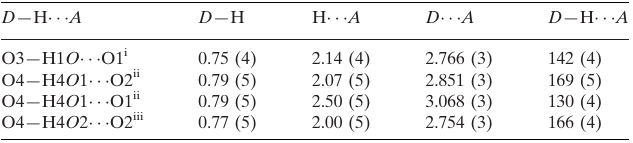
Hydrogen-bond geometry (A˚ , (cid:3)